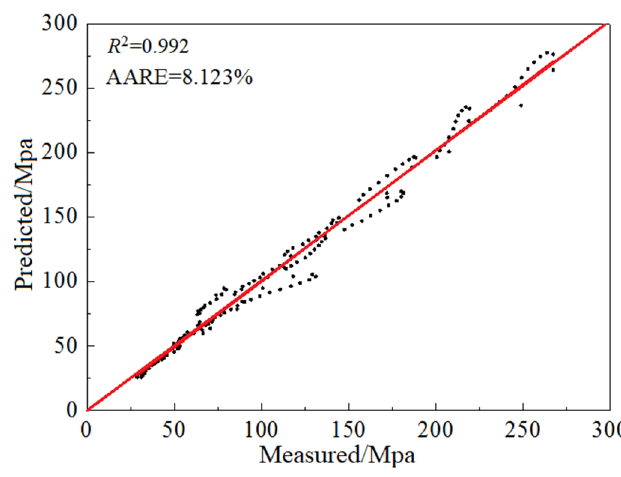
Figure 12. Measured versus the predicted stress.